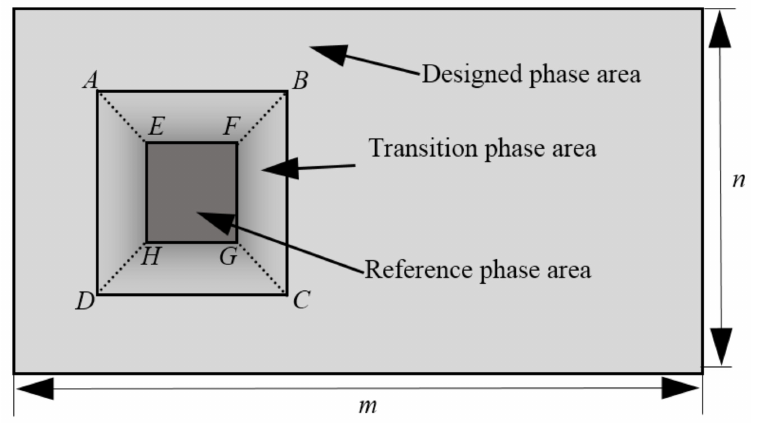
Figure 3. The gray map to get the global phase response of the LcoS-SLM. The whole phase map is divided into three parts. The area outside the rectangle ABCD is set with the designed phase, changing from 0 to 2 π . The area of inner rectangle EFGH is set with a reference phase of zero. The middle part between them is assigned with a gradual changing phase value to connect the designed phase the reference phase part. Then each pixel’s phase change is calculated by subtracting the reference phase in the inner rectangle. The interferometer could get the phase of the measured wavefront from optical path difference (OPD) data. It normally shows a result with the tilt section of the wavefront removed, which is not needed in the proposed method. It would also disturb the overall consistency of the measuring sequence. Hence, the tilt section should be reserved as the raw measured data and it could be adjusted by subtracting the first measured reference wavefront in the sequence. During the calibration process, the input map’s greylevel changes from 0 to 255 with a rectangular reference area set as 0. The data from the first series is the global phase response except the reference rectangle on the left. And then the second series of phase maps are used to get the opposite part of phase response. At last, the two part of data is combined to generate the global phase response of the LcoS-SLM by a merging algorithm. In Figure 4, both left and right sequences of 18 holograms to calibrate the phase response of the LcoS-SLM before and after